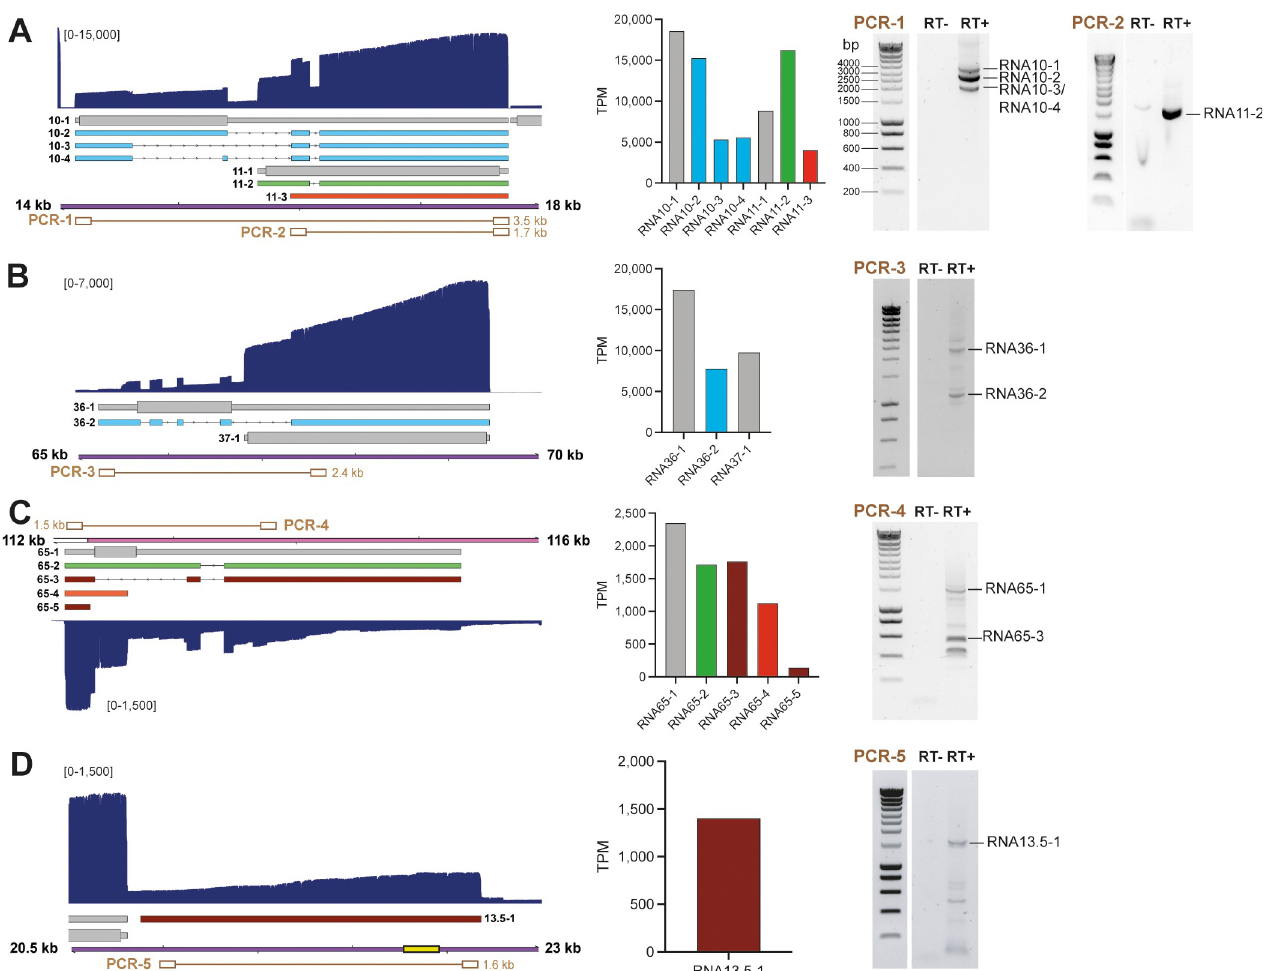
Fig 2. Confirmation of selected novel SVV transcripts by RT-PCR. (A-D) Examples of a polycistronic transcription units encoding canonical transcripts, novel splice variants and fusion transcripts within the RNA10 and RNA11 locus (A) and RNA36 and RNA 37 (B), canonical, spliced and variant isoforms and putative ncRNAs in the RNA65 locus (C) and newly identified putative ncRNA13.5–1 (D). The structure, location and relative expression levels of novel SVV transcripts are shown, together with agarose gel images of RT-PCRs that confirm their expression. Left panels: Nanopore dRNA-seq coverage plots with annotated SVV transcripts of lytically infected BS-C-1 cells. Canonical with CDS (wide box) and UTR (thin box) in (grey), variant (orange), splice variant (green), fusion transcripts (blue) and non-coding (red) RNAs are indicated. Double black lines represent the SVV genome, with UL in purple fill, US in pink and IRS/TRS no fill, ticks indicate 1 kb intervals and the reiterative repeat regions R1 to R4 and both copies of OriS are indicated as yellow boxes on the genome track. Middle panels: bar graphs indicating transcripts per million (TPM) counts for each transcript isoform. Right panels: RT-PCR was performed on RNA extracted from lytically SVV-infected BS-C-1 cells at 96 hpi. RT+/RT-: reverse transcriptase added or omitted during cDNA synthesis. PCR numbers correspond to primer pairs indicated in brown in Figure A-D and in S5 Table. When multiple bands are observed, sequence confirmed bands are indicated.